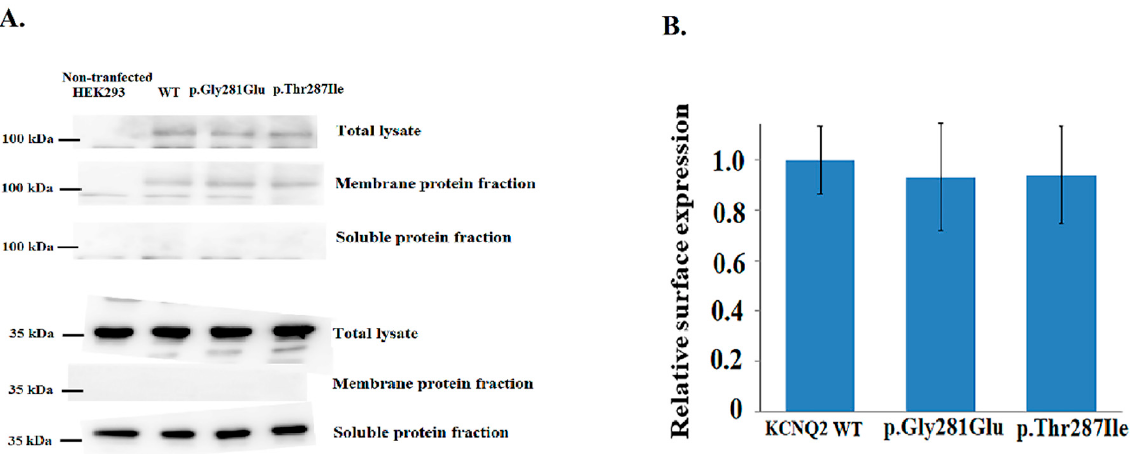
Figure 7. ( A ) Western blotting demonstrated the protein expression in KCNQ2 WT, p.Thr287Ile, and p.Gly281Glu. KCNQ2 protein expression was not significantly ( n = 3) (Supplementary Figure S1) different in p. T287I and p. Gly281Glu. Protein expression on cell membranes did not differ significantly for both mutations and KCNQ2 WT. ( B ) Western blotting demonstrated the protein expression in KCNQ2 WT, p.Thr287Ile, and p.Gly281Glu. KCNQ2 protein expression was not significant ( n = 3).